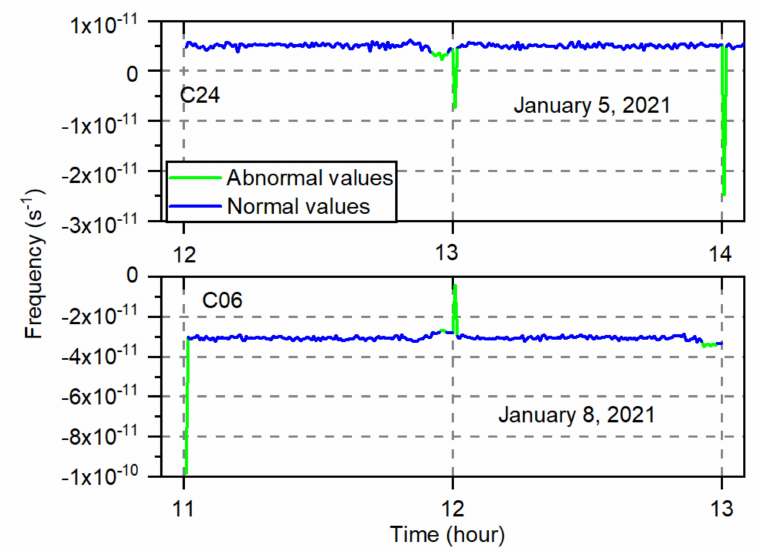
Figure 4. Frequency data of C06 and C24 satellite clocks and the outlier detection results.